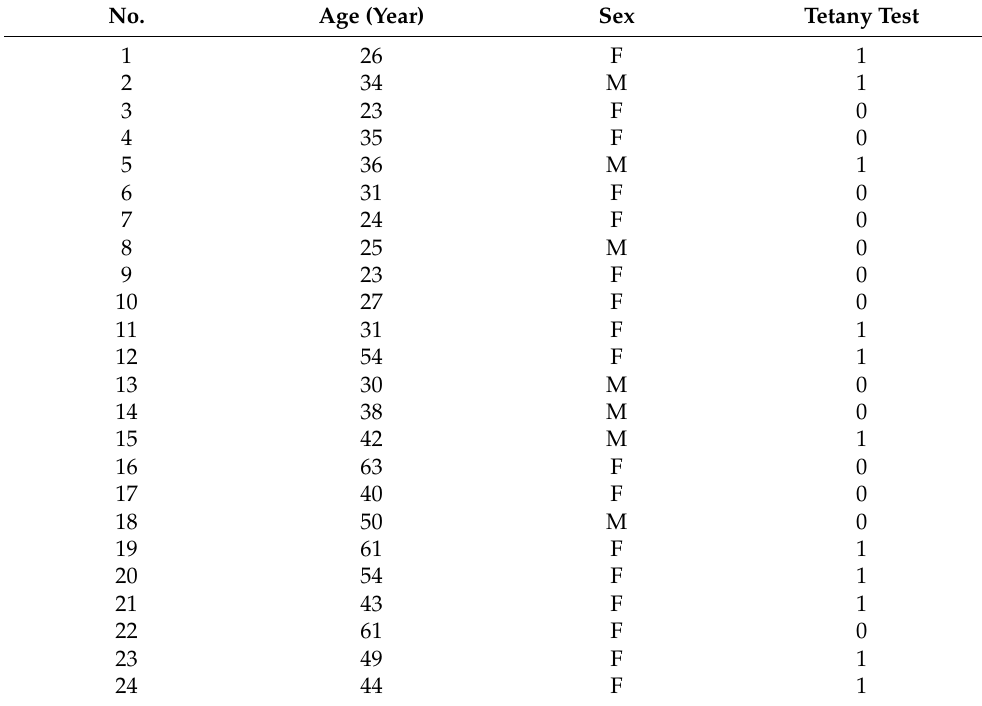
Table 2. Demographic data and the results of the tetany test in the control group ( n = 24).